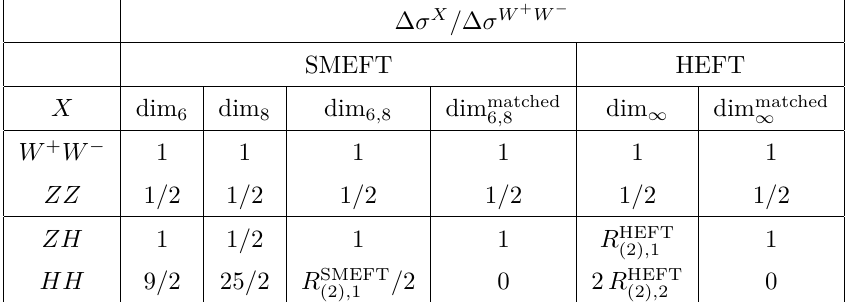
Table 1 . Ratios of final-state cross-section deviations in diboson production, assuming that the leading muon-Yukawa contribution originates from various combinations of d = 6 and d = 8 op- erators in SMEFT, or from a direct contribution in the HEFT, respectively. The term “matched” indicates the matching to a model with a vanishing muon-Yukawa coupling. See the text for details. The coefficients R are defined in (2) ,i